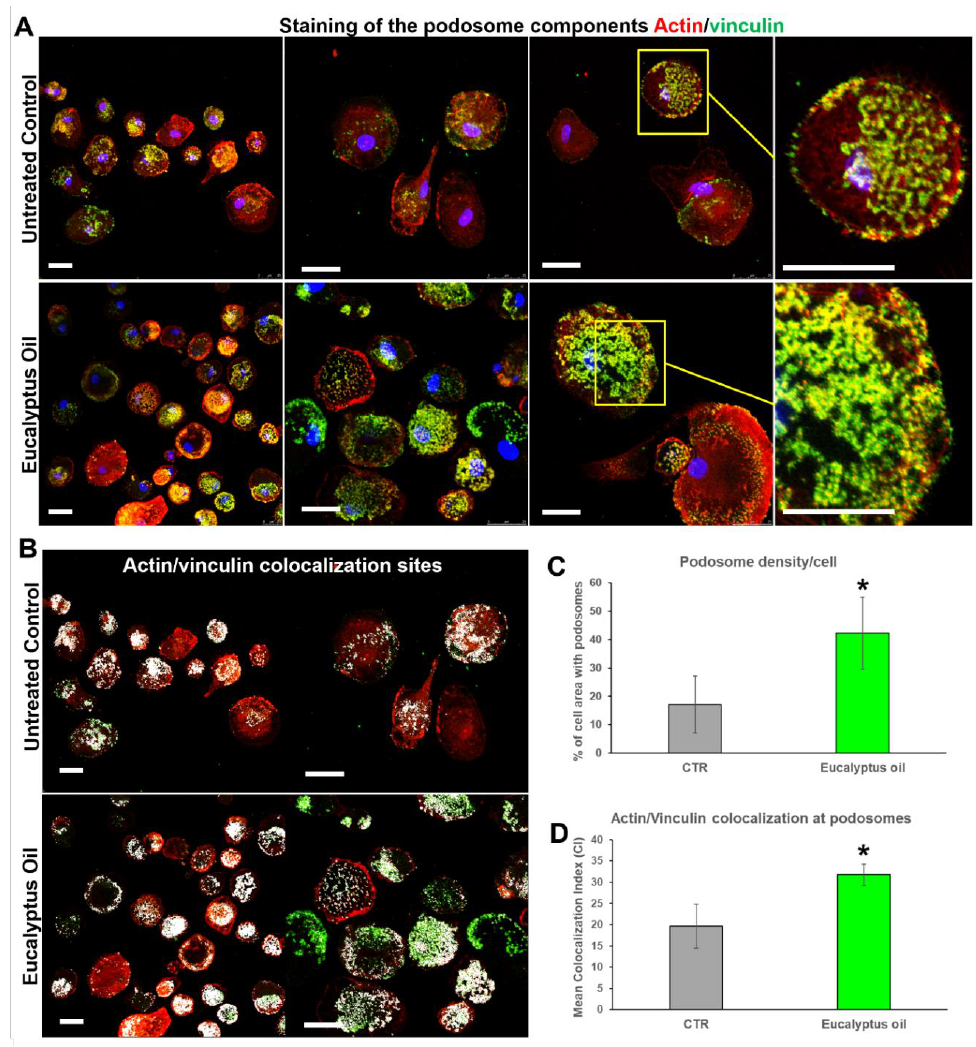
Figure 6. Effect of Eucalyptus oil on actin and vinculin distribution at the podosomes of human MDM. ( A ) Confocal microscopy showing the association of vinculin (green hue) with the actin-rich dot-shaped contacts (red hue) at the cell adhesion sites (yellow hue) of macrophages treated for 24 h with 0.008% EO and of untreated control. Cells were double-stained for F-actin, using the TRITC-phalloidin, and for vinculin, using the specific monoclonal antibody, as described in Materials and Methods. Cell nuclei were counterstained with 0.2% Hoechst. Fields at increasing magnification are shown. Bars = 25 µ m. ( B , D ) Confocal microscopy ( B ) showing the colocalization regions (white areas) of actin and vinculin at the podosomes, and a bar graph ( D ) reporting the mean colocalization indexes (CI) calculated as described in Materials and Methods, in control and EO-stimulated MDMs. Bars = 25 µ m. ( C ) Quantitative analysis of podosome density/cell (percent of total cell area occupied by podosomes) in control and EO-stimulated MDMs, performed by using the ImageJ processing software. Quantification of CI and the podosome density have been carried out by analyzing a minimum of 100 cells/sample and results are the mean ± SD from three independent experiments ( n = 3). Significance (two-tailed Student’s t -test) vs. CTR, * p <